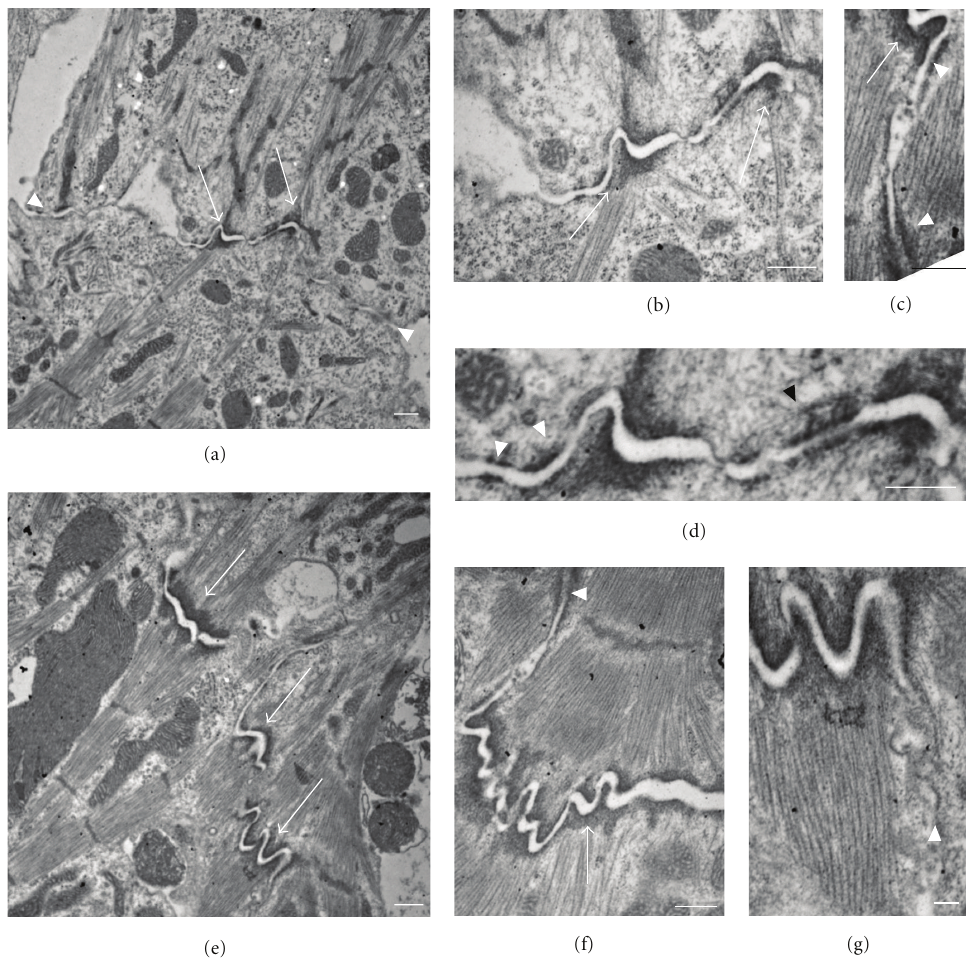
Figure 3: Ultrastructural analysis of new cardiomyocyte cell-cell contacts at 5-days post plating. At this timepoint, cell contacts form and develop rapidly, allowing the observation of both nascent (a, b, d) and more mature (c, e, f, g) contact sites. (a) Remodeling cardiomyocytes extend fingerlike projections (arrowheads) that interact with neighboring cells to form adhesive contacts (arrows) thereby electromechanically linking the two cells. (b, d) Higher magnifications of an adhesive domain indicated in (a) shows insertion of actin filaments into nascent adherens junctions (AJs) (arrows in (b)). Note the nascent (white arrowheads in (d)) and more mature (black arrowhead in (d)) desmosomal contacts in close proximity to the maturing AJ. (c) A mature adhesive domain again demonstrates desmosomal contacts (arrowheads) near a newly formed adherens junction (arrow). (e)–(g) More mature adhesive contacts demonstrate adherens junctions (arrows in (e)) at the insertion of the terminal actin filaments of newly formed myofibrils, along with closely associated desmosomal contacts (arrowhead in (f)) and gap junctions (arrowhead in (g)). Scale bars are 500 nm (a)–(f) and 100 nm